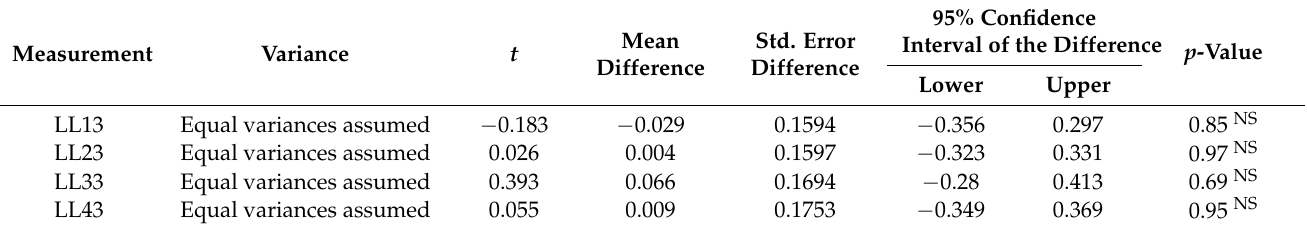
Table 4. The mean difference between two mean using independent sample-t-test for the labiolingual (LL) width of maxillary and mandibular